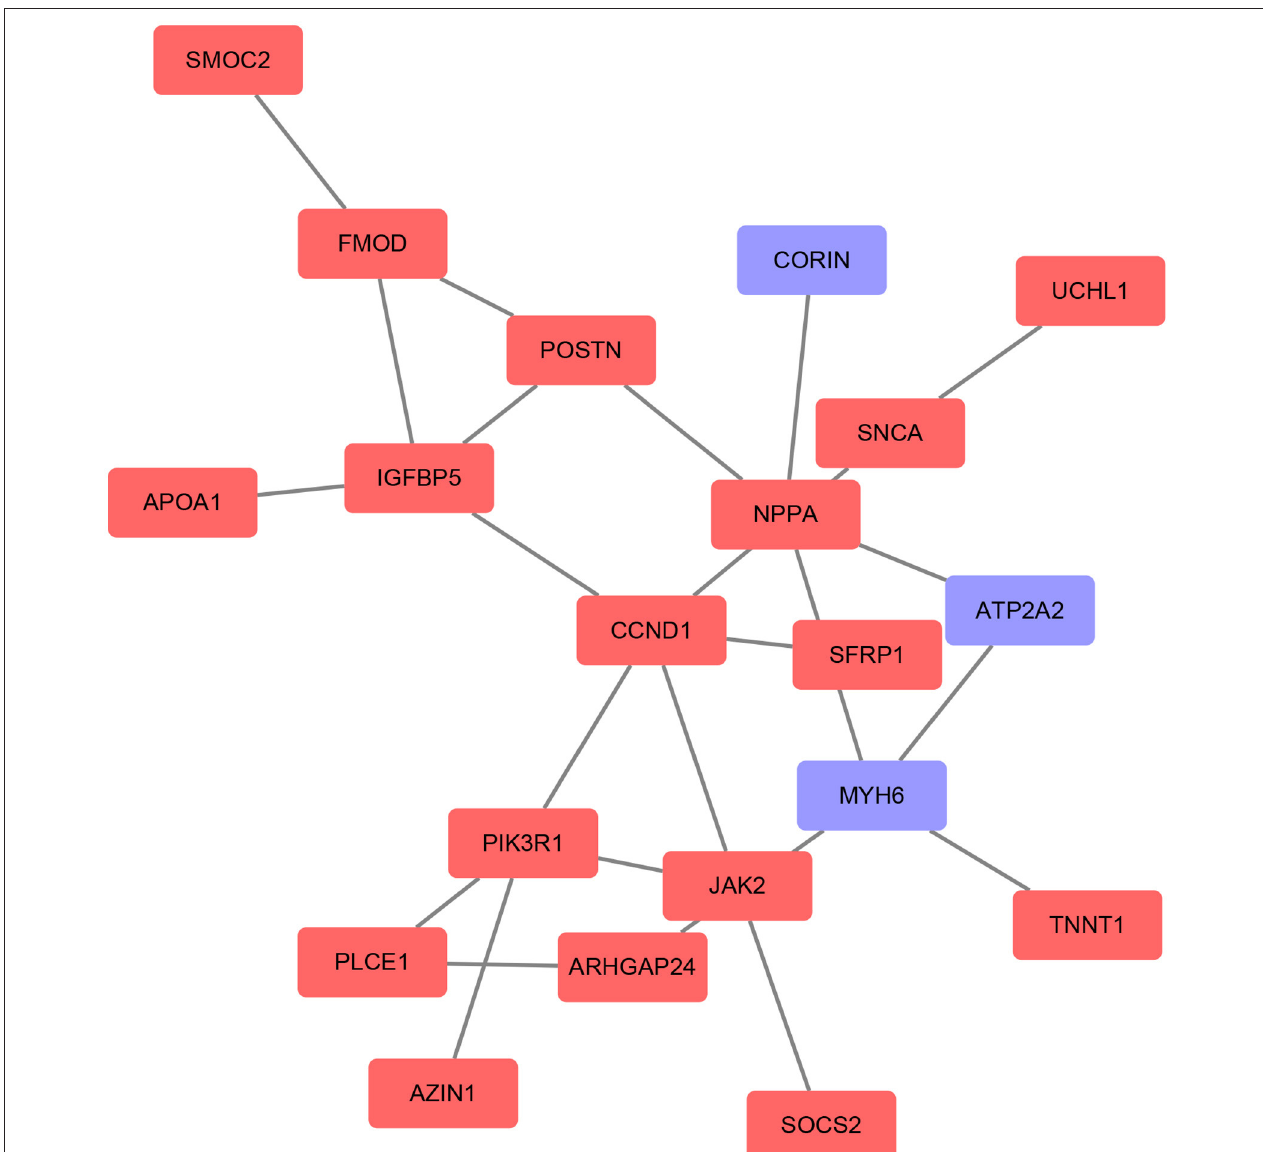
FIGURE 5 | Protein–protein interaction (PPI) networks of the DEGs were constructed based on the STRING database and Cytoscape software. The red point represents upregulated genes and the blue point represents downregulated